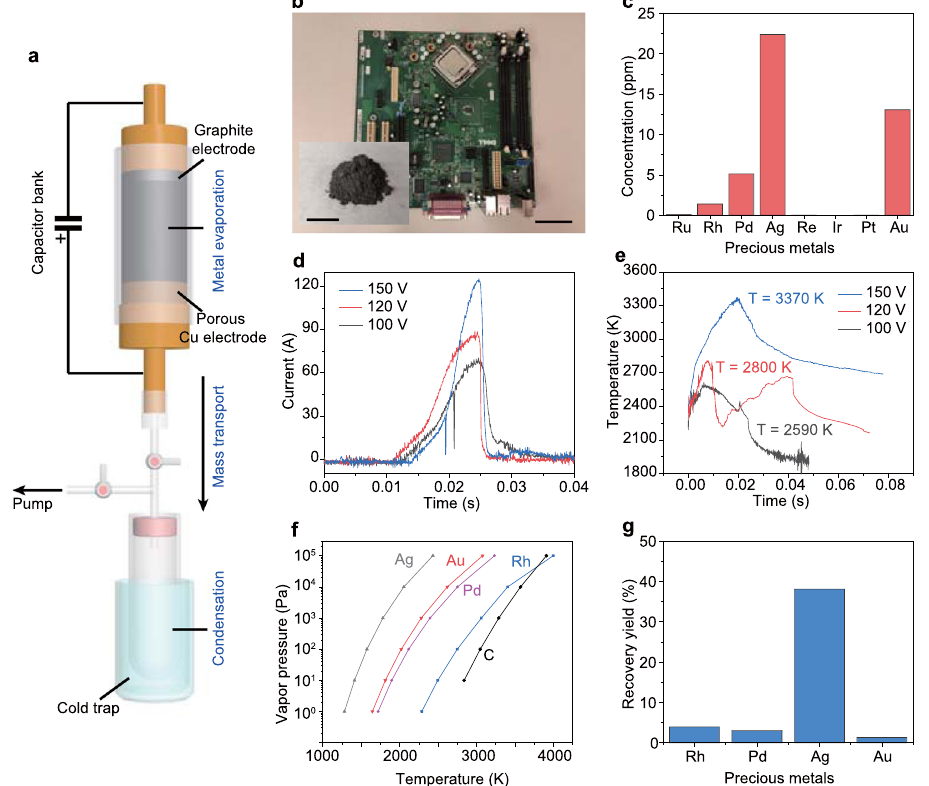
Fig. 1 Recovery of precious metals by fl ash Joule heating (FJH). a Schematic of the FJH and evaporative separation system. The system was composed of three parts, including FJH for metal evaporation, the vacuum system for mass transport, and the cold trap for volatiles condensation. b Picture of a printed circuit board (PCB). Scale bar, 5 cm. Inset, the mixture of carbon black (CB) with PCB powder. Scale bar, 2 cm. c Concentrations of precious metals in PCB as determined by inductively coupled plasma mass spectrometry (ICP-MS). d Currents vs time recorded under different FJH voltages. e Real-time temperature measurements at different FJH voltages by fi tting blackbody radiation emitted from the sample. f Vapor pressure – temperature relationship